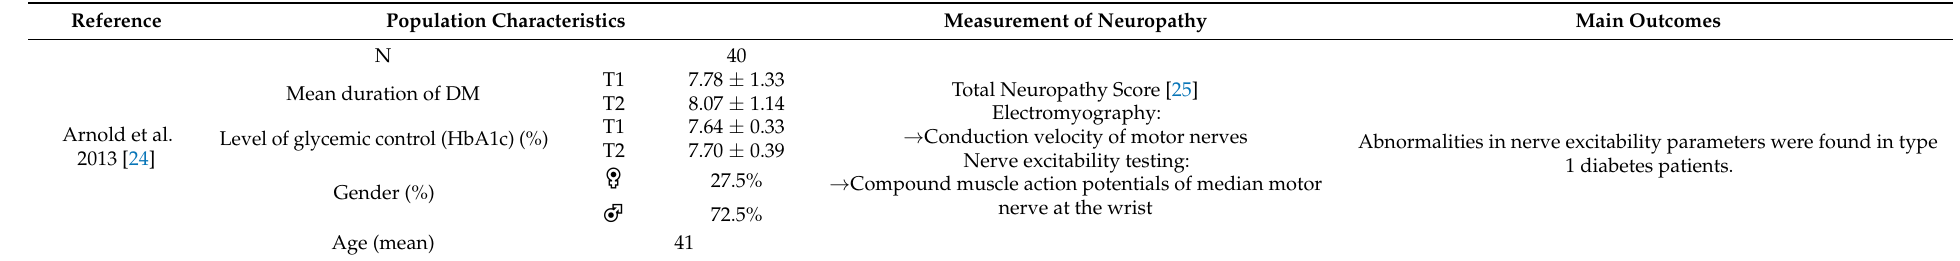
Table 1. Differences between type 1 (T1) and type 2 (T2) diabetes in sensory neuropathy. Table 2. Cont .